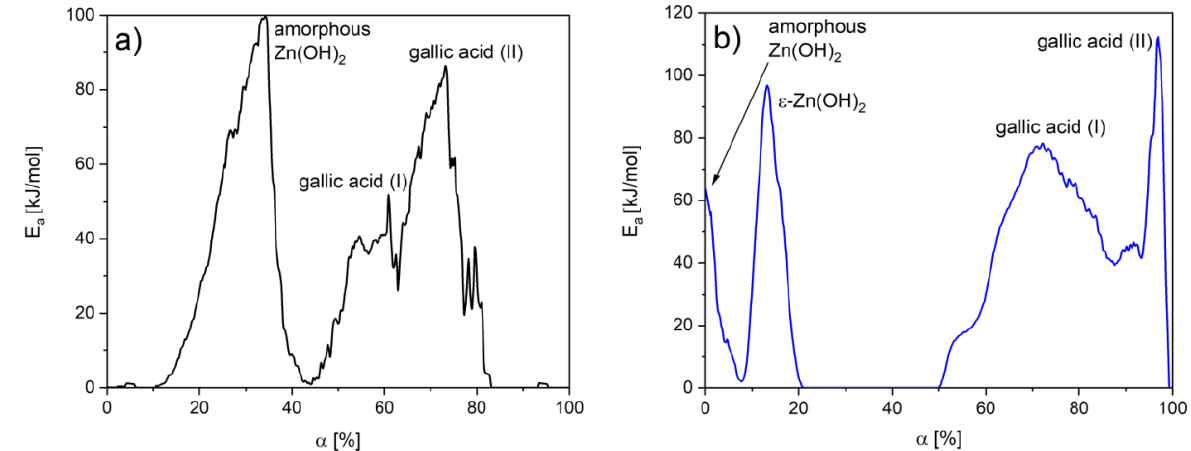
Figure 5. E a changes as a function of conversion degree in the sample: ( a ) BT1, ( b ) BT3.